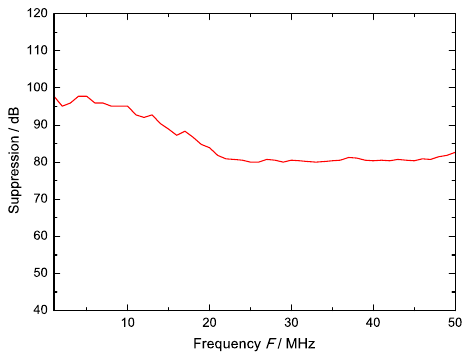
Figure 8. Carrier suppression ratio of the analog signal chain based on the gated amplifier.